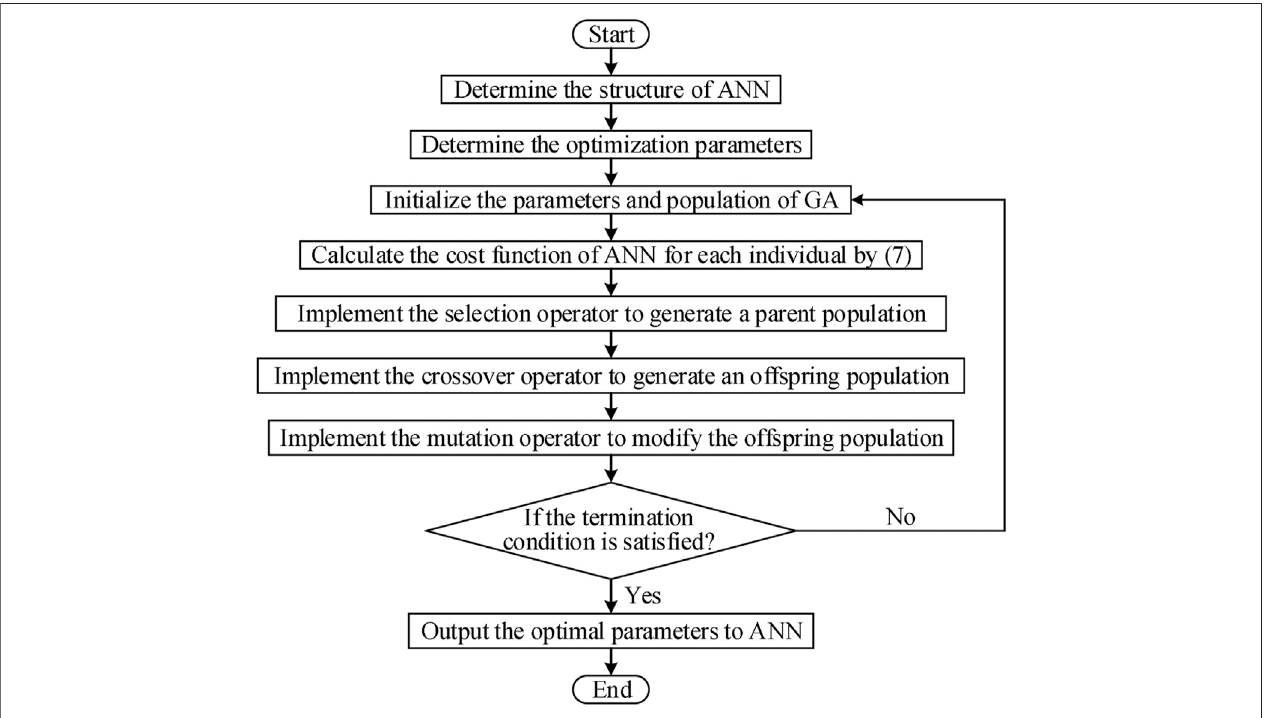
FIGURE 3 | Detailed steps of ANN training by a